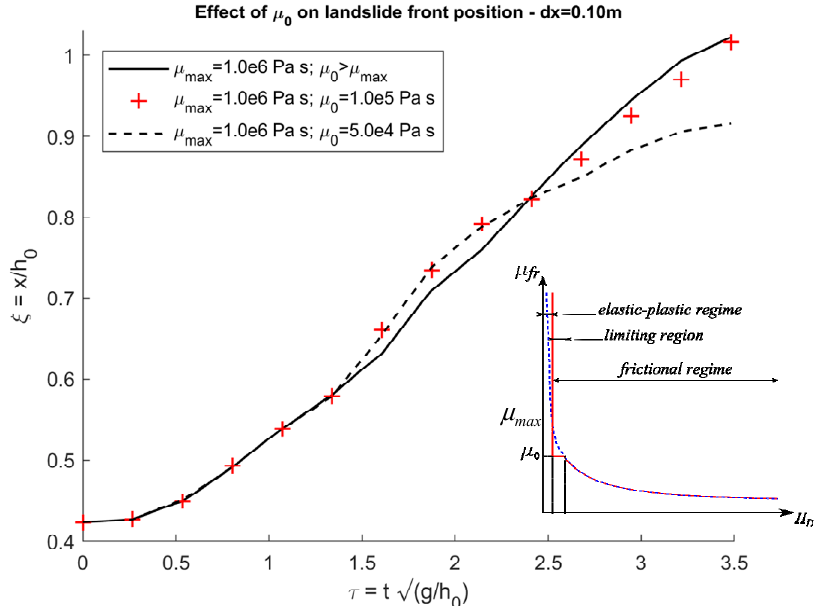
Figure 3. E ff ect of limiting viscosity µ 0 on landslide front propagation. Non-dimensional front position Figure 3. Effect of limiting viscosity μ 0 on landslide front propagation. Non-dimensional front ξ as function of non-dimensional time τ position ξ as function of non-dimensional time τ .